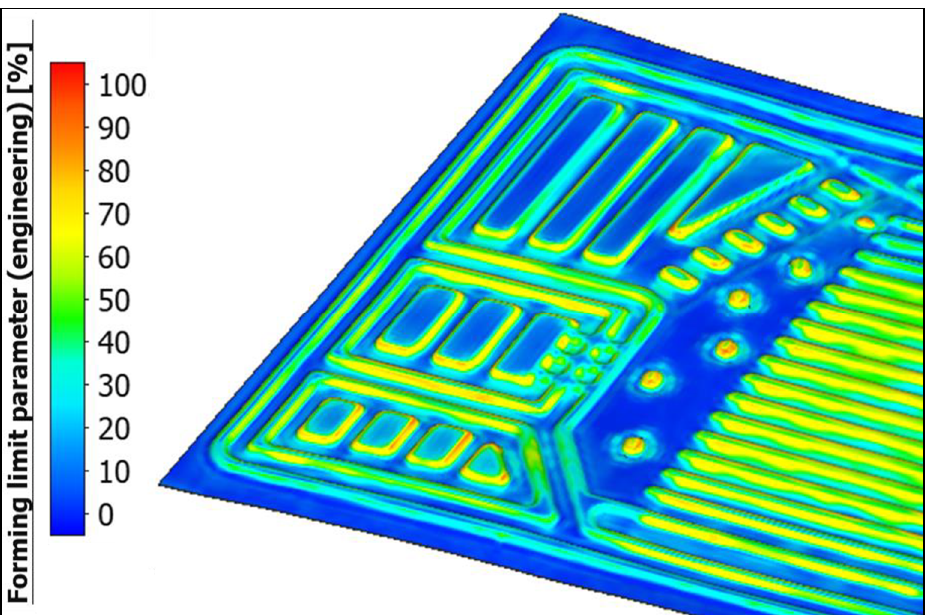
Figure 8. Utilization of the forming limit of the metal foil.